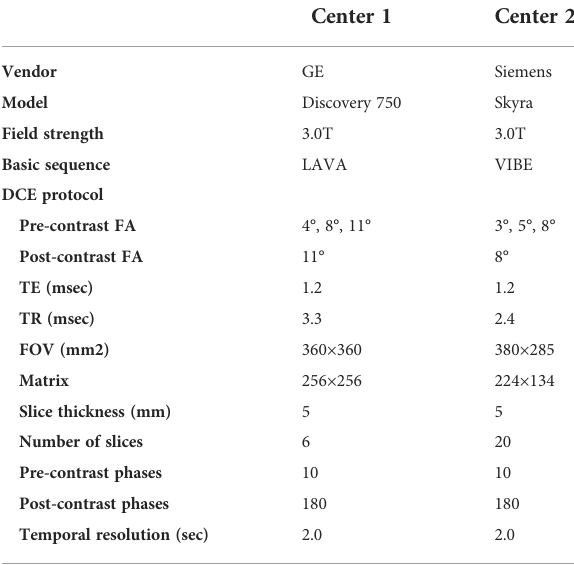
TABLE 1 Parameters of DCE MRI acquisition